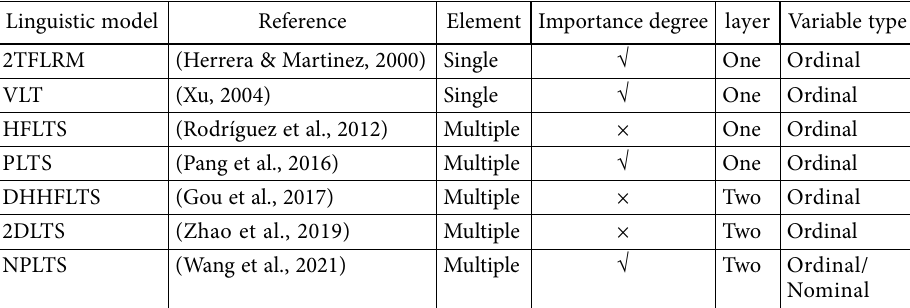
Table 1. The characteristics with linguistic representation models (source: our research) Linguistic